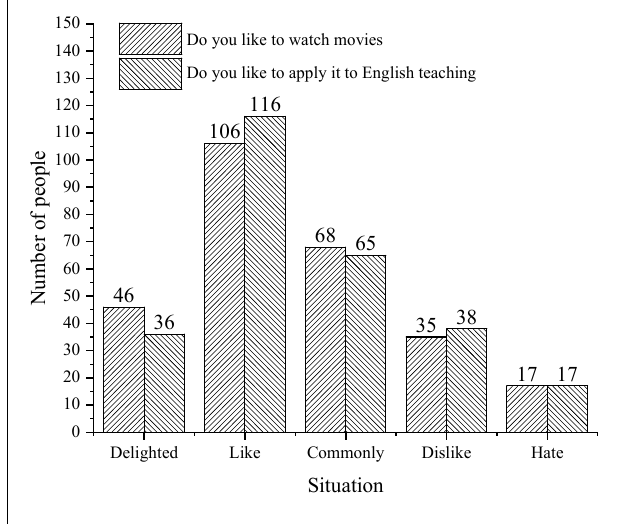
FIGURE 8 | Students’ attitude survey.